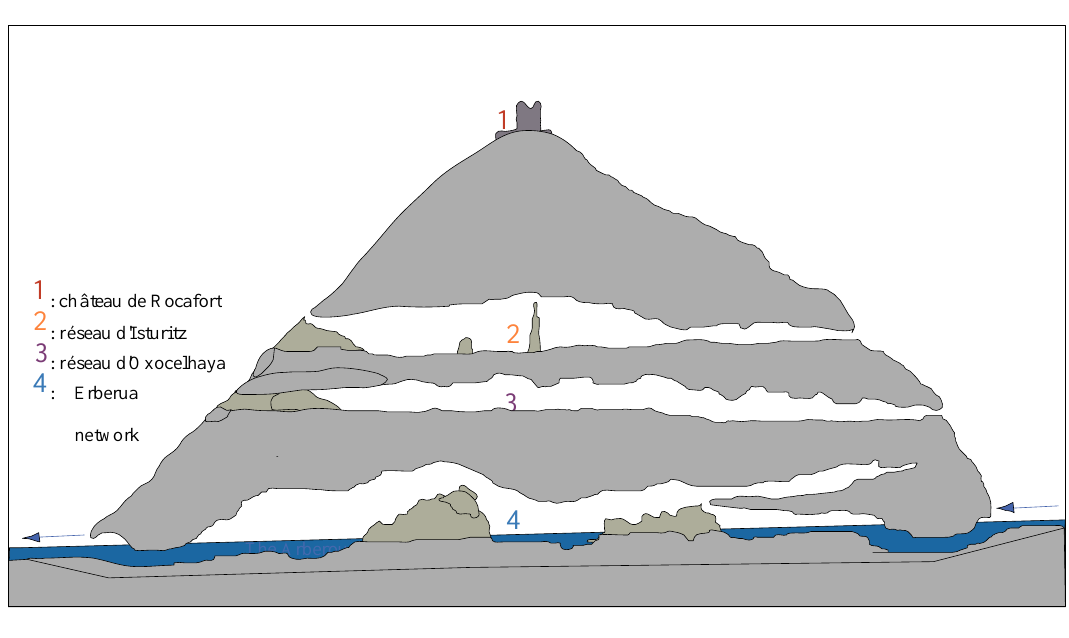
Figure 3. Schematic cross section of the Gaztelu